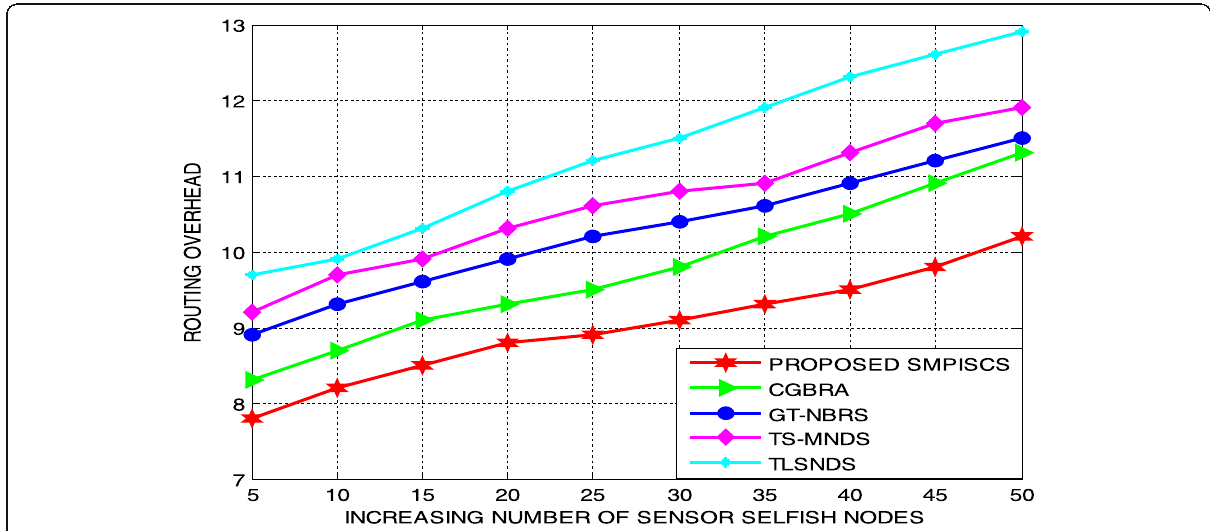
Fig. 9 SMPISCS-Routing Overhead (with selfish sensor